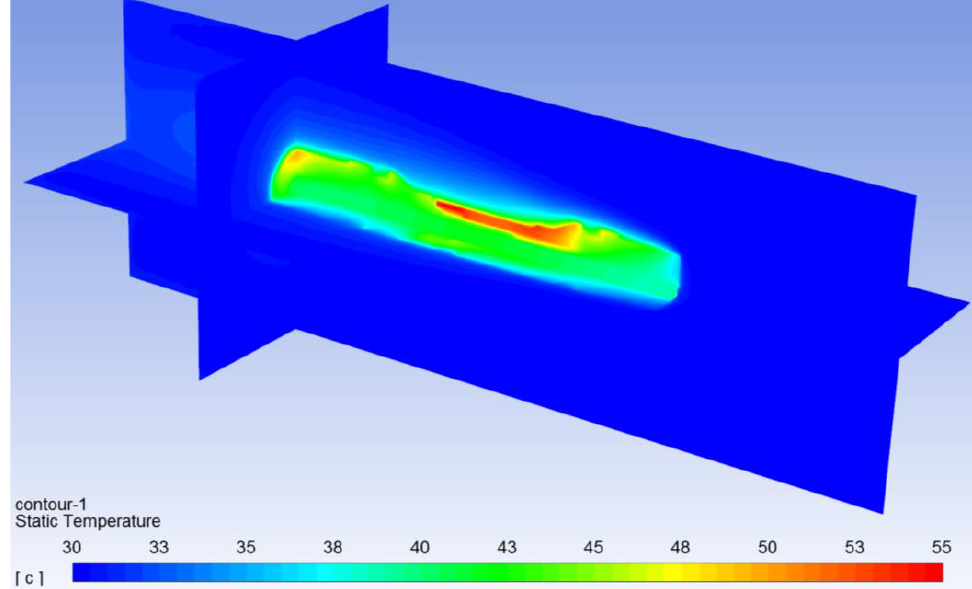
Figure 7. Temperature distribution around DC connector without current flow ( I = 0 A) and with solar radiation. Max temperature: 55 °C.